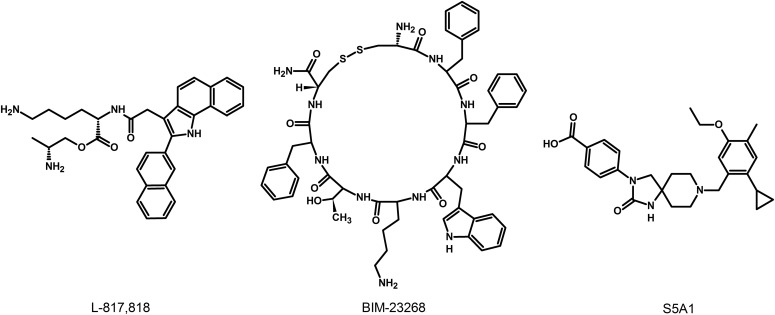
Structures of synthetic SST5 ligands. L-817,818 and BIM-23268, SST5 agonists; S5A1, SST5 antagonist.